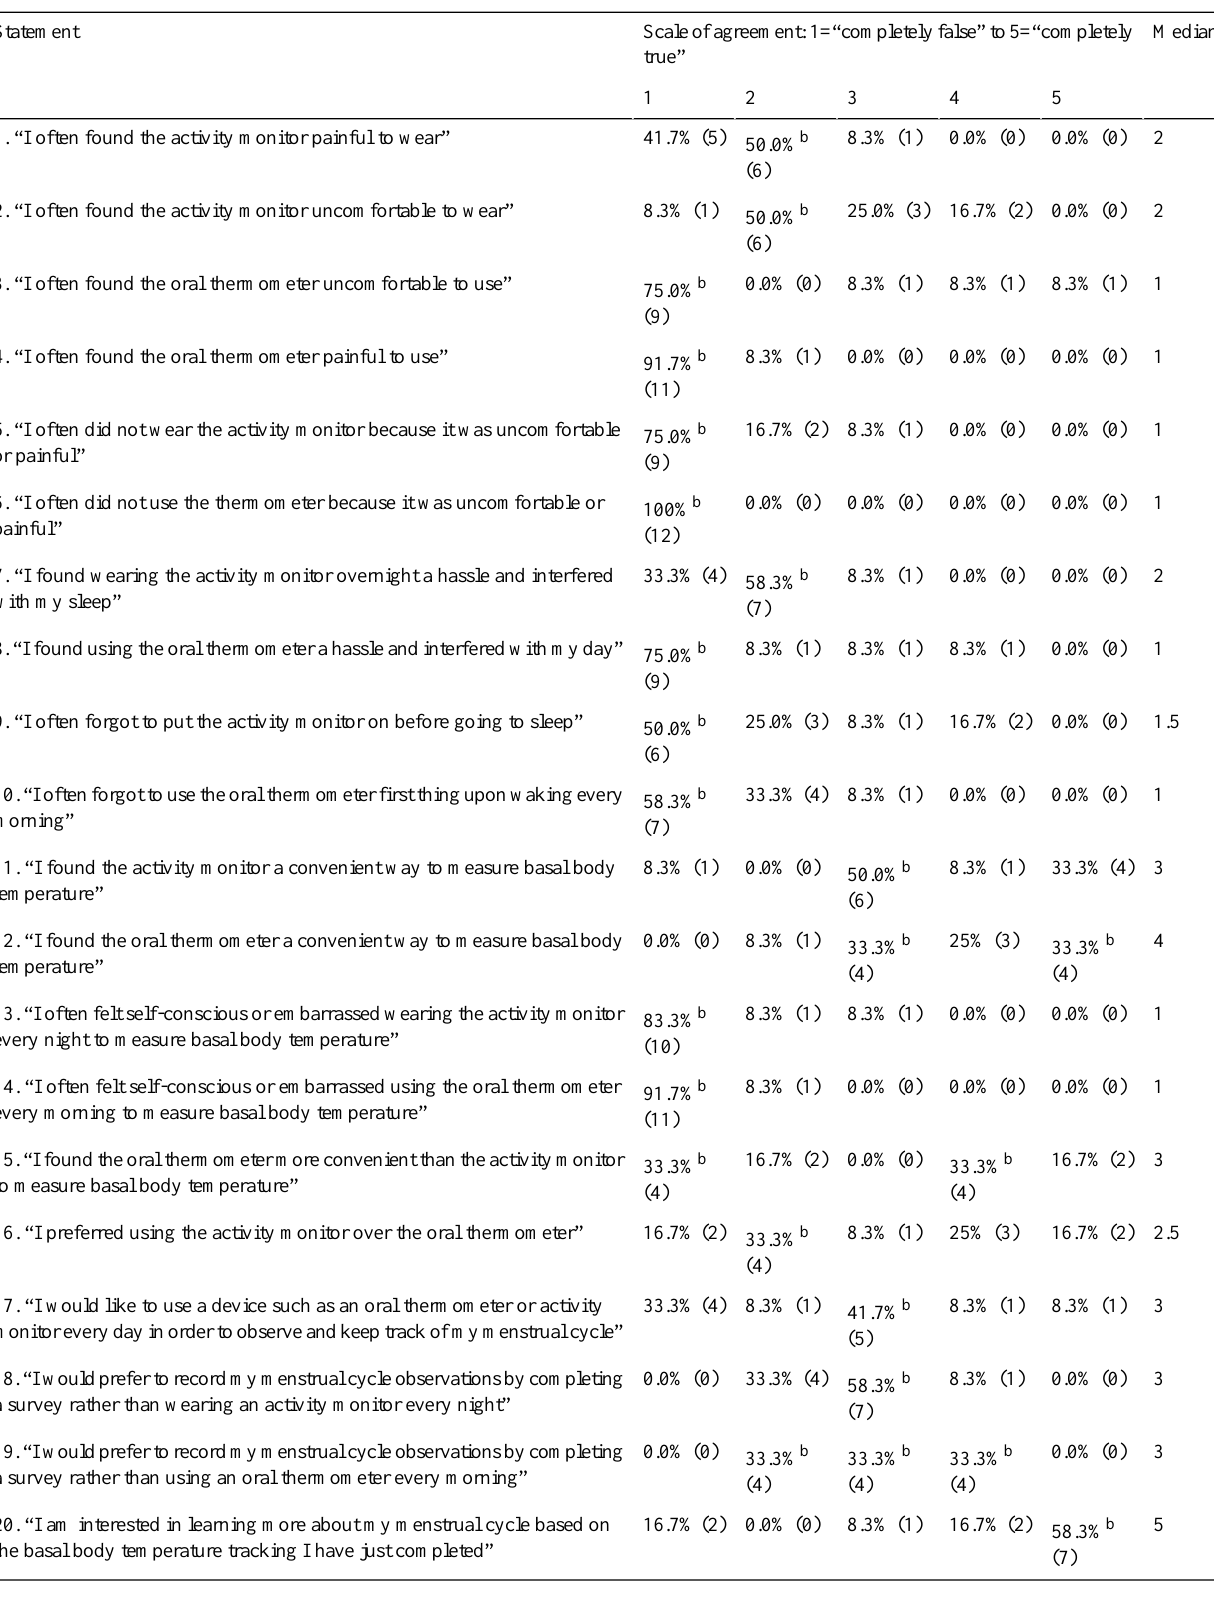
Table 4. Summary of participant responses a to questions asked on their experience using both the BMSW and the thermometer in the post data collection feedback questionnaire.